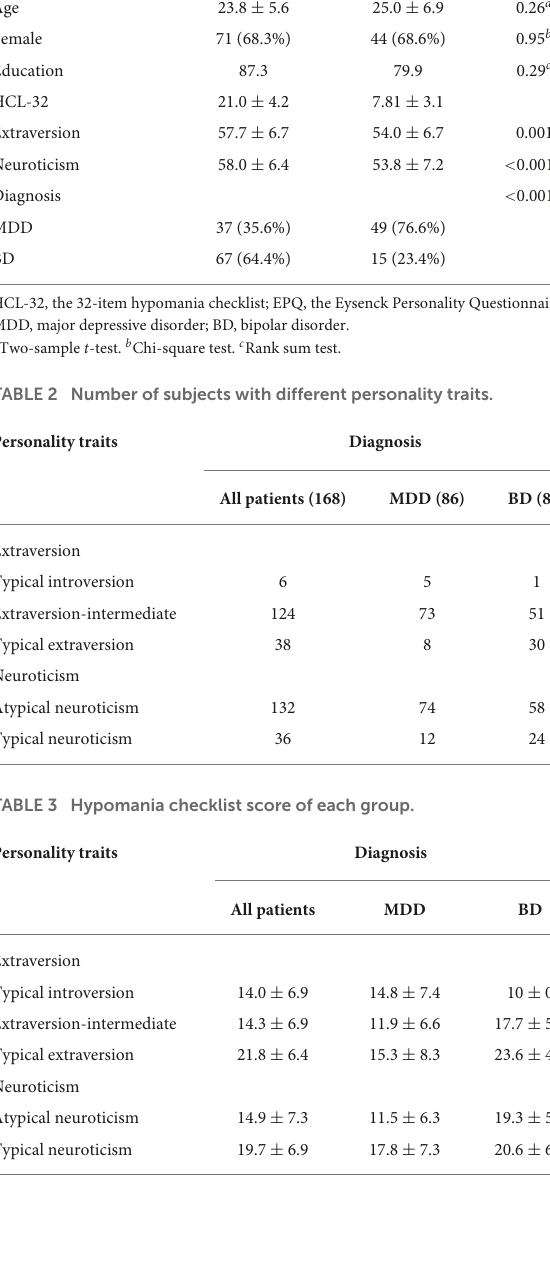
TABLE 1 Demographic characteristics and psychological scale results of patients.